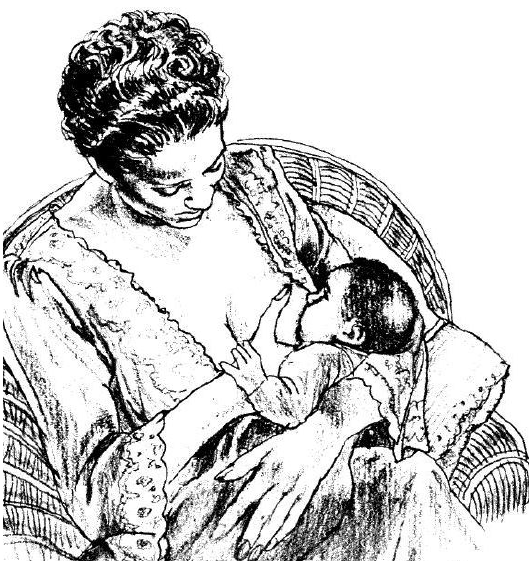
Figure 10. How to Figure 10. How to breastfeed.